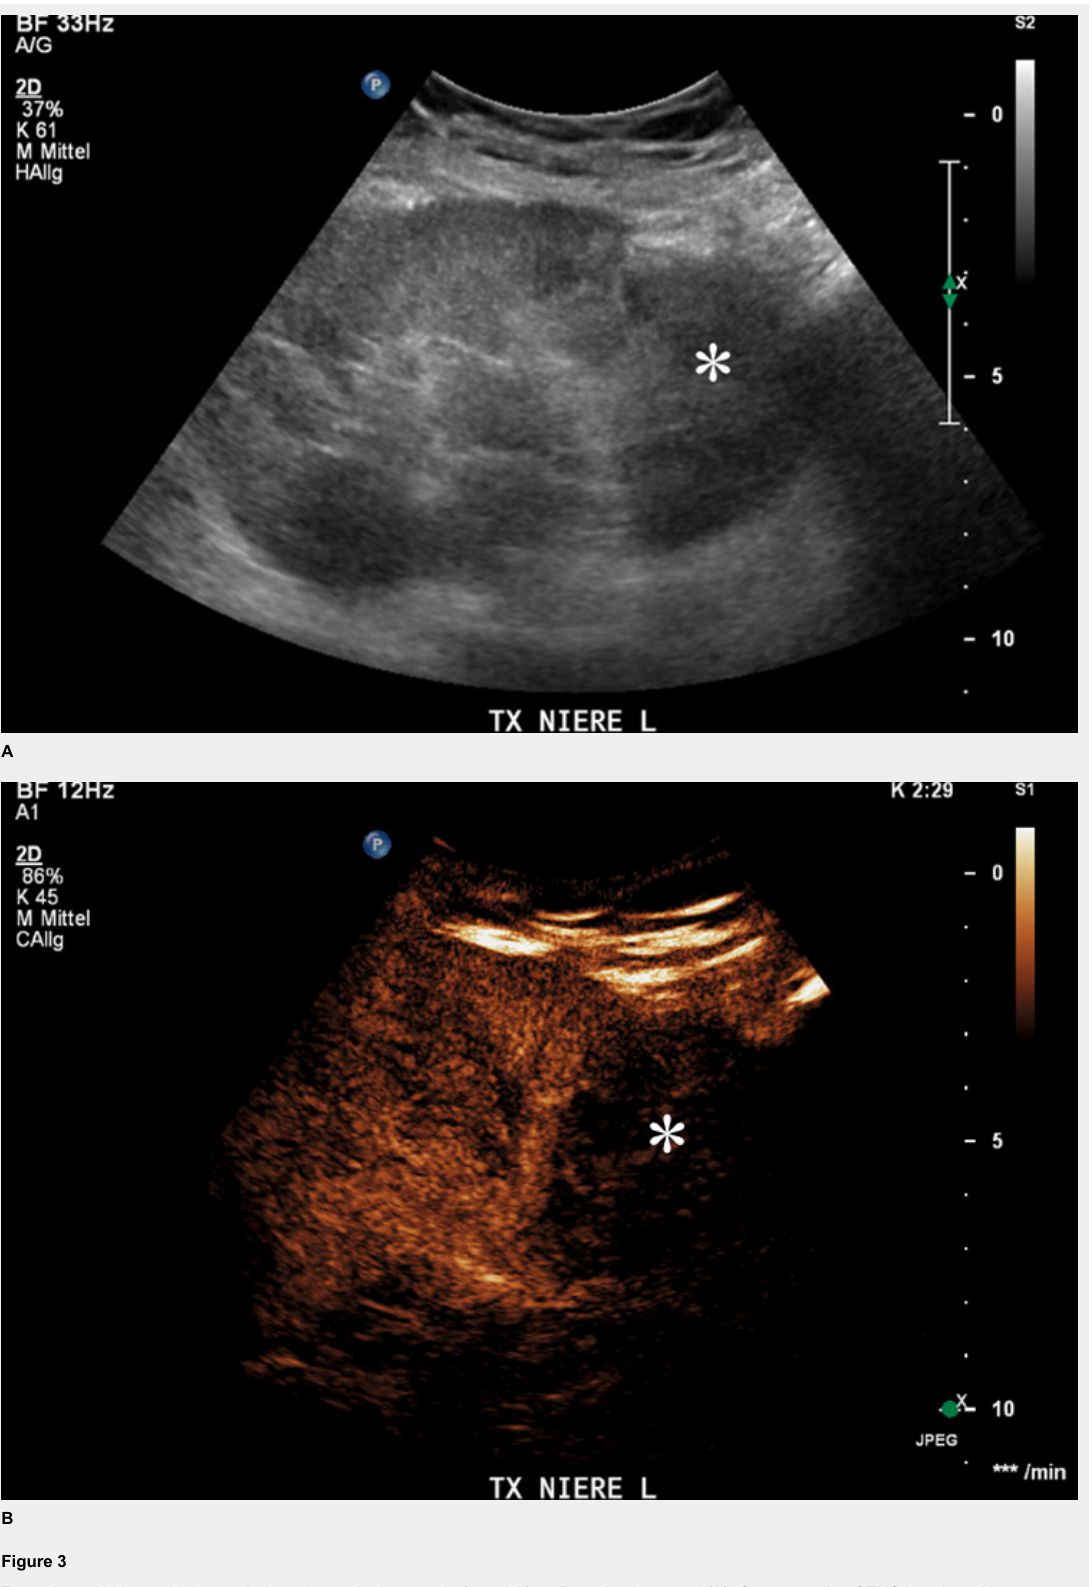
Figure 3 Transplanted kidney with hypoechoic region at the lower pole (asterisk) on B-mode ultrasound (A). Corresponding CEUS imaging with devascularised region at the lower pole (asterisk) in the transplanted kidney